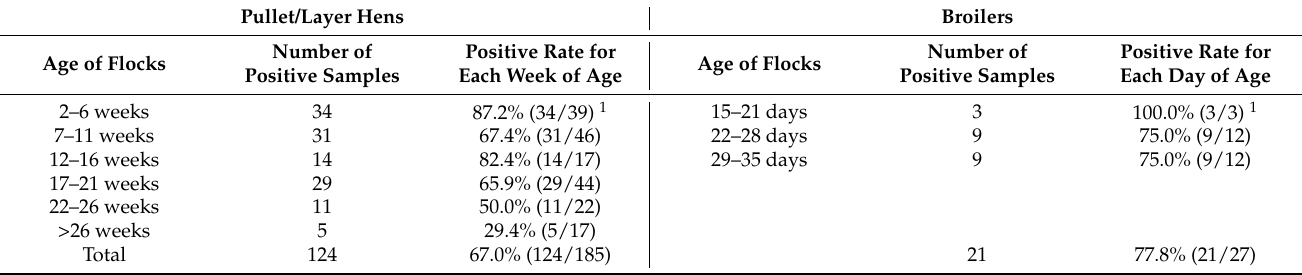
Table 6. The number and positive rate of viral infections according to the ages of layer and broilers flocks.